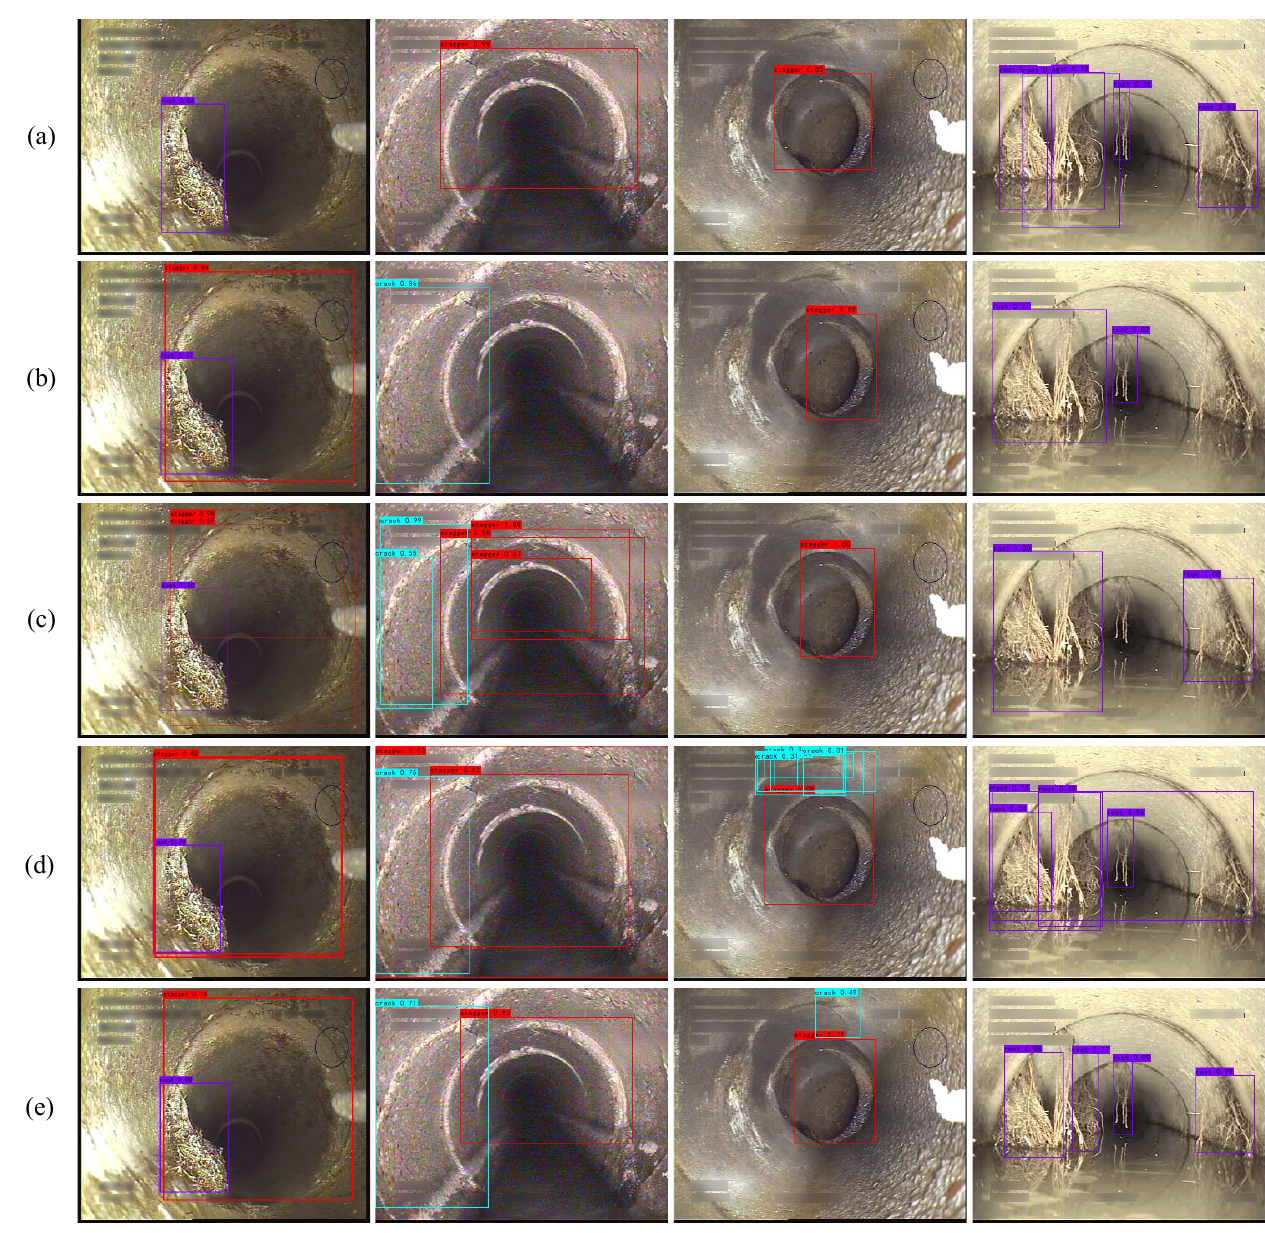
Figure 11. Some detection results of sewer defect images using different models: ( a – d ) show the detection results by YOLOv3, YOLOv7, Faster R-CNN and DETR, respectively; ( e ) shows the detection results by our model.